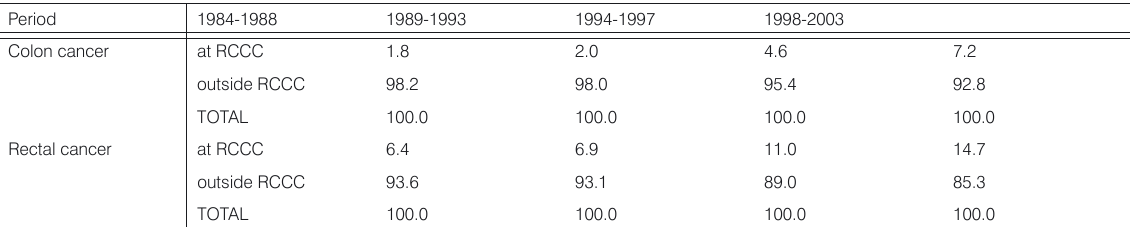
Table 3. Percentages of colon and rectal cancer cases diagnosed in Lower Silesia and treated surgically at the Regional Comprehensive Cancer Center (RCCC) in Wroclaw between 1984